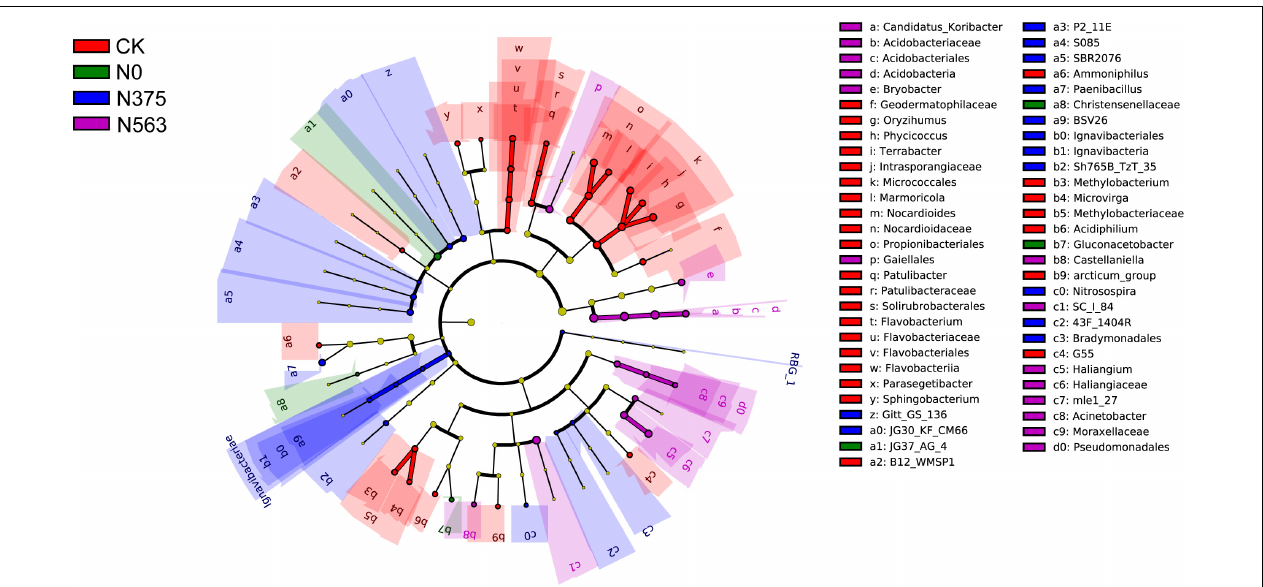
FIGURE 4 | The taxa of bacteria with significantly different abundance in the treatments were identified with the LEfSe method. Colored circles indicate the differentially abundant taxa and the color is corresponding to the different treatments (red for CK, green for N0, blue for N375, and purple for N563). Six rings of the cladogram stand for domain (innermost), phylum, class, order, family, and genus, and lineages with LDA values higher than 2.0 are